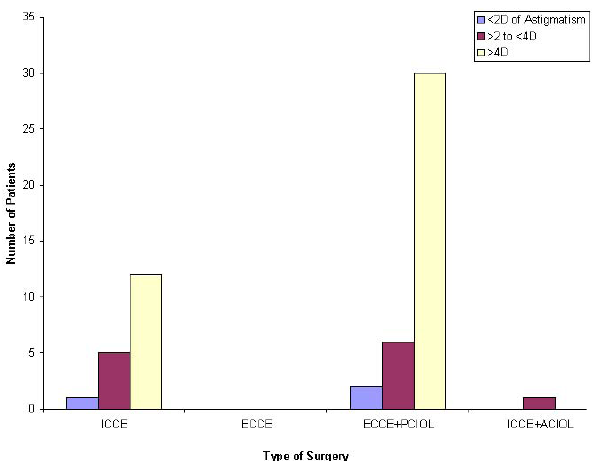
Figure 2 Number of patients with different degress of astigma- tism in the different